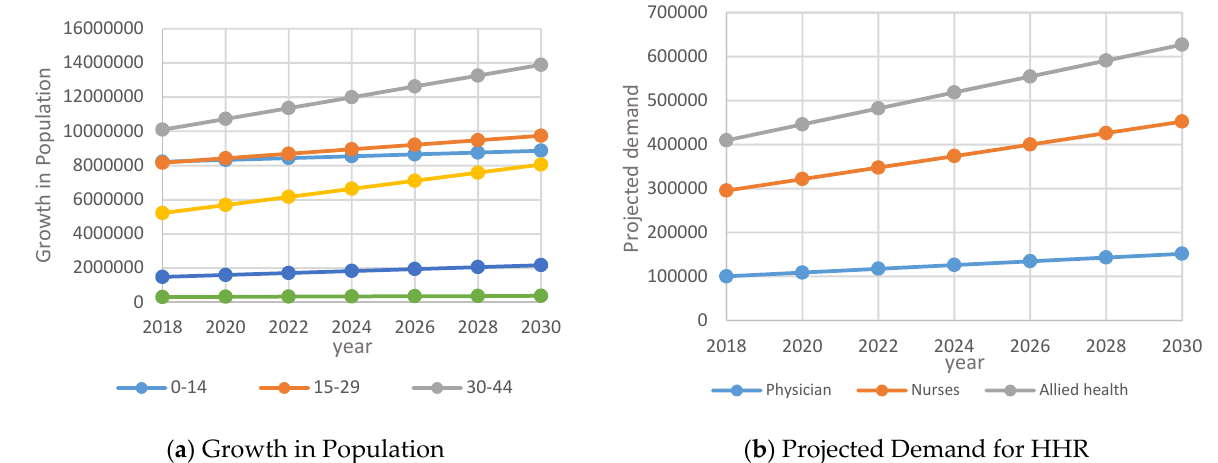
Figure 7. Extrapolated data for growth in population and HHR between 2018 and 2030: ( a ) Growth in Population; ( b ) Projected Demand for HHR.